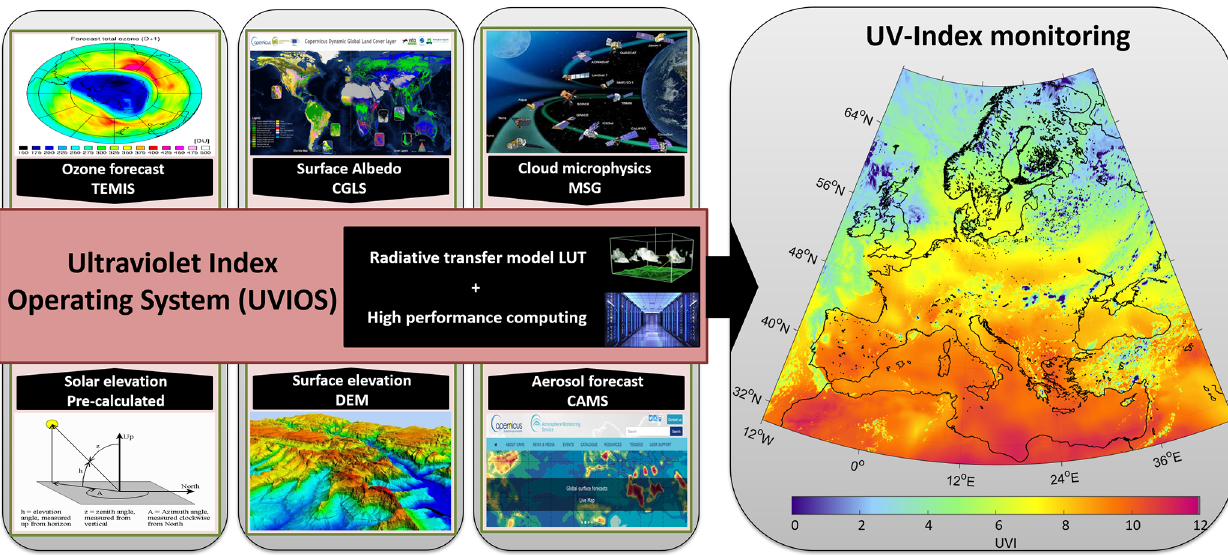
Figure 1. Flowchart illustration of the UVIOS modeling technique scheme. The pre-calculated effects of solar and surface elevation and albedo followed by the aerosol and ozone forecasts and the real-time cloud observations to the UVIOS solver result in the spectrally weighted output of UVI for the European region.